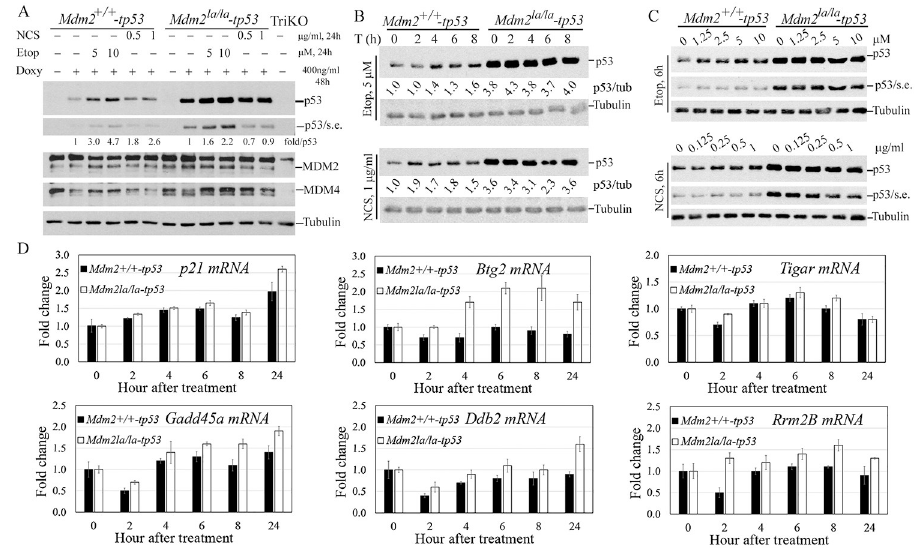
Fig 5. E3 ligase activity of MDM2 is required for an intact p53-dependent DNA damage checkpoint response. ( A ) p53 restoration by Tet-inducible system and effect of DNA damage on p53 accumulation after 24h treatment. Mdm2 +/ + -tetp53 and Mdm2 la/la -tetp53 MEFs were treated with 400ng doxycycline (Doxy) for 24h to induce p53 expression followed by treatment with the indicated concentrations of etoposide and NCS for 24h before WB analysis for p53, MDM2 and MDM4 with tubulin as loading control. S. expo, short exposure. TriKO, p53 -/- /Mdm2 -/- /Mdm4 -/- triple knockout MEFs as negative control. Normalized p53 levels against tubulin shown as fold/p53. ( B ) Mdm2 la/la -tetp53 MEFs lacks rapid p53 response after DNA damage. The indicated MEFs were treated similarly as in B except with 5 μ M etoposide (upper) or 1 μ g/ml NCS for indicated hours before WB analysis. P53/tub, normalized p53 levels first against tubulin then against the p53 levels in non-treated Mdm2 +/+ -tetp53 MEFs. ( C ) Mdm2 la/la MEFs failed to accumulate p53 at early time points after DNA damage. The MEFs were treated similarly as in B except with indicated concentrations of etoposide or NCS for 6h before WB analysis. ( D ) qPCR analysis of p53 target gene activation over the indicated time course after NCS treatment using Gapdh as an internal control of input